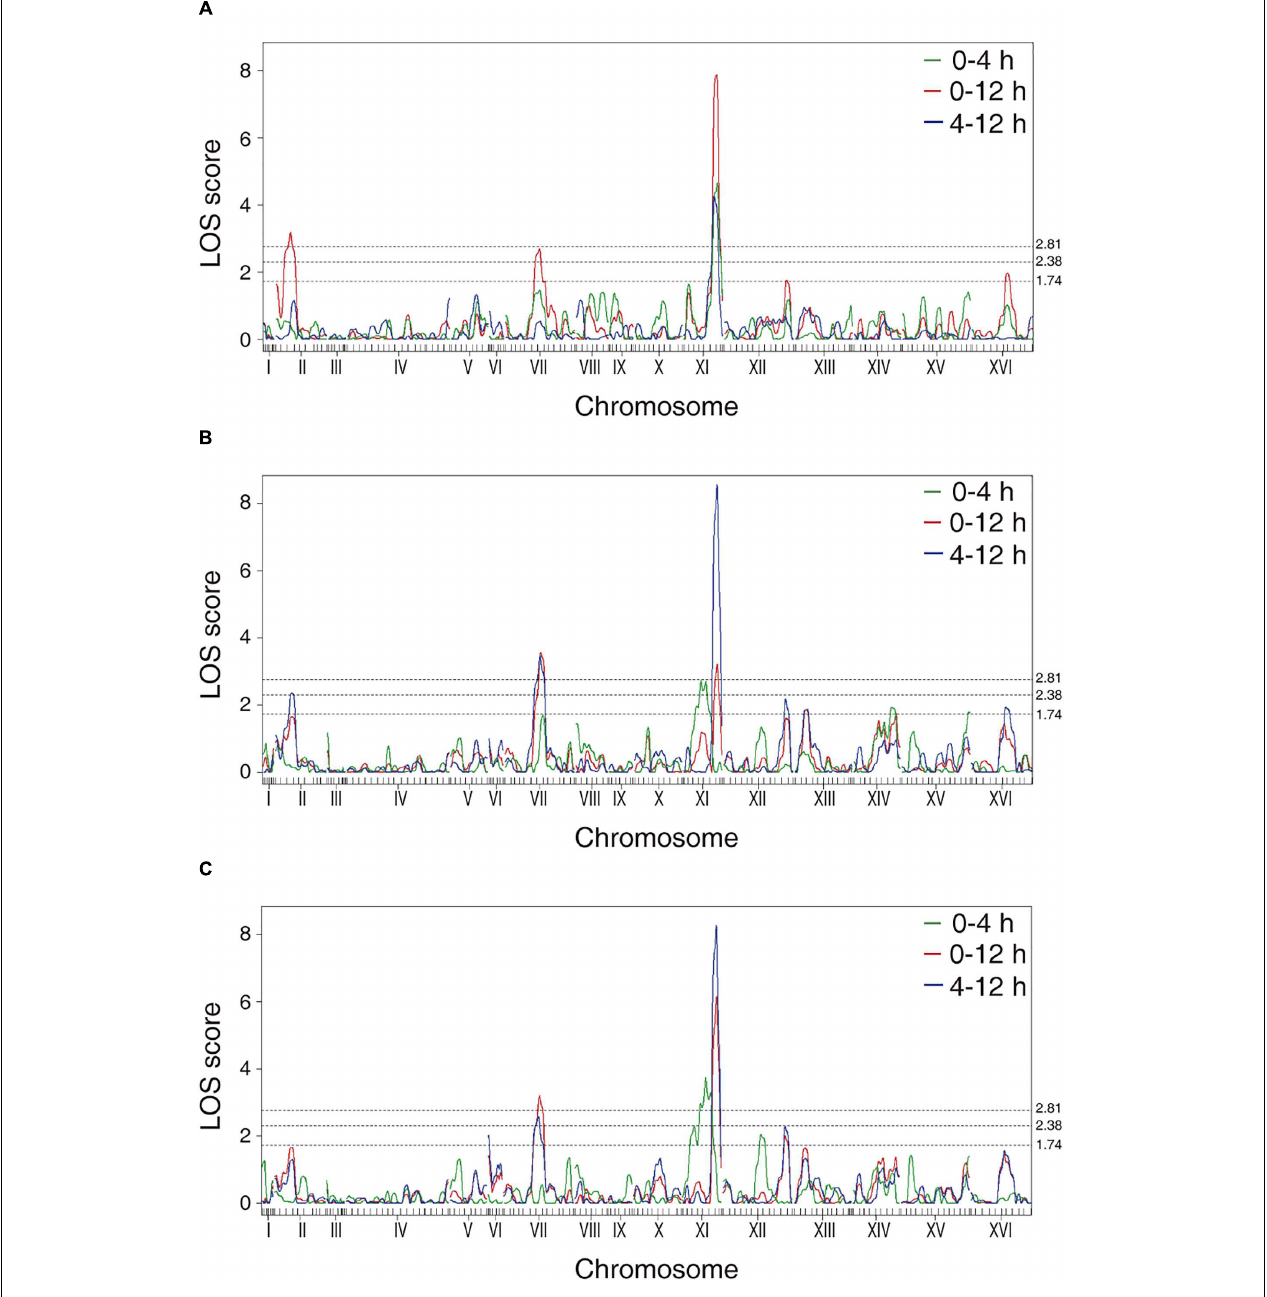
FIGURE 1 | LOD scores for the mapped QTLs. The graphs represent the results obtained for the phenotypes of (A) time in which the maximum luminescence is obtained, (B) maximum luminescence and (C) area under the curve of luminescence. The dotted lines correspond to the LOD scores of 2.81 ( p -value < 0.05), 2.38 ( p -value < 0.15), and 1.74 ( p -value <